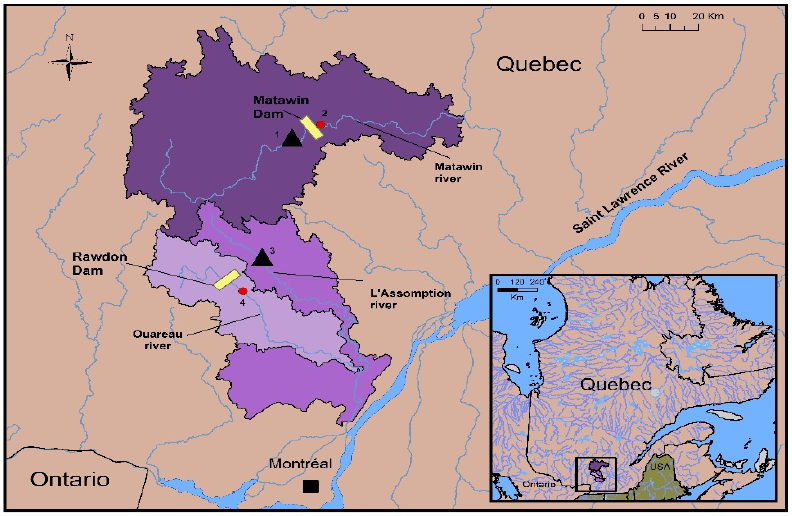
Figure 1. Location of the L’Assomption River and Matawin River watersheds. 1 = Saint-Michel des Saint station; 2 = Matawin downstream from dam station; 3 = Joliette station; and 4 = Oureau downstream from dam station.